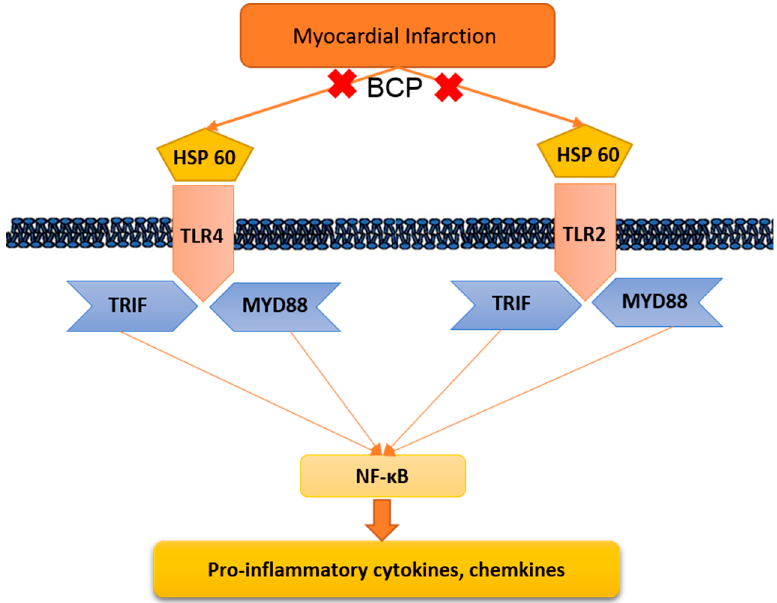
Figure 9. Suggested roll of β -caryophyllene on Toll-like receptor signaling. HSP-60: Heat shock protein 60; TLR2: Toll-like receptor 2; MYD88: Myeloid differentiation primary response gene 88; TRIF: TIR-domain-containing adapter-inducing interferon- β ; and NF κ B: Nuclear Factor- κ B. β -Caryophyllene provokes a full agonist action on cannabinoid type 2 (CB2) receptors, which